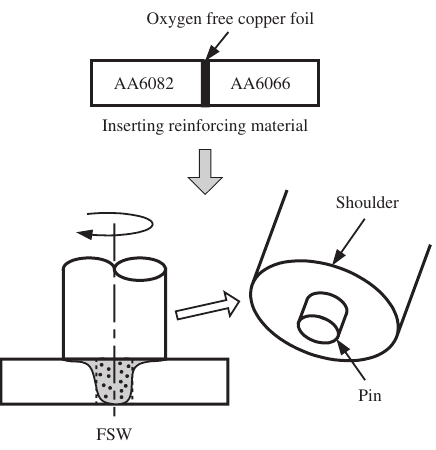
Figure 1: Schematic illustration of the friction-stir butt welding process.